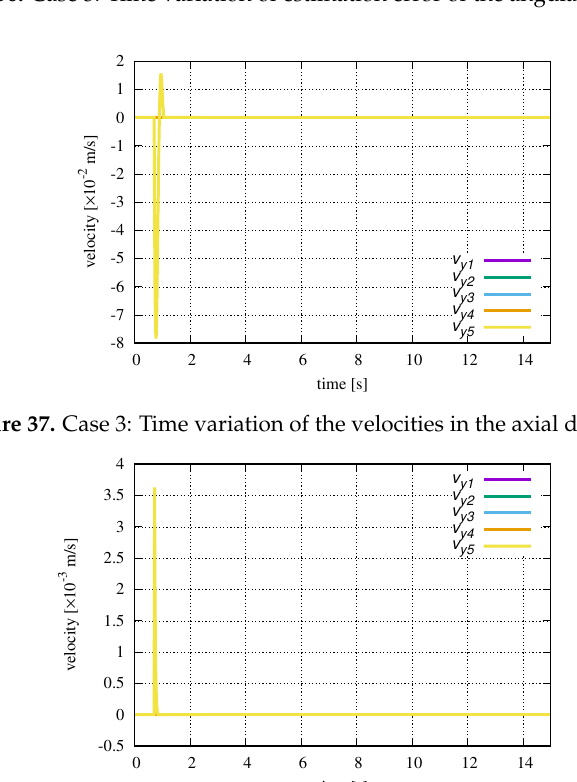
Figure 36. Case 3: Time variation of estimation error of the angular velocities.